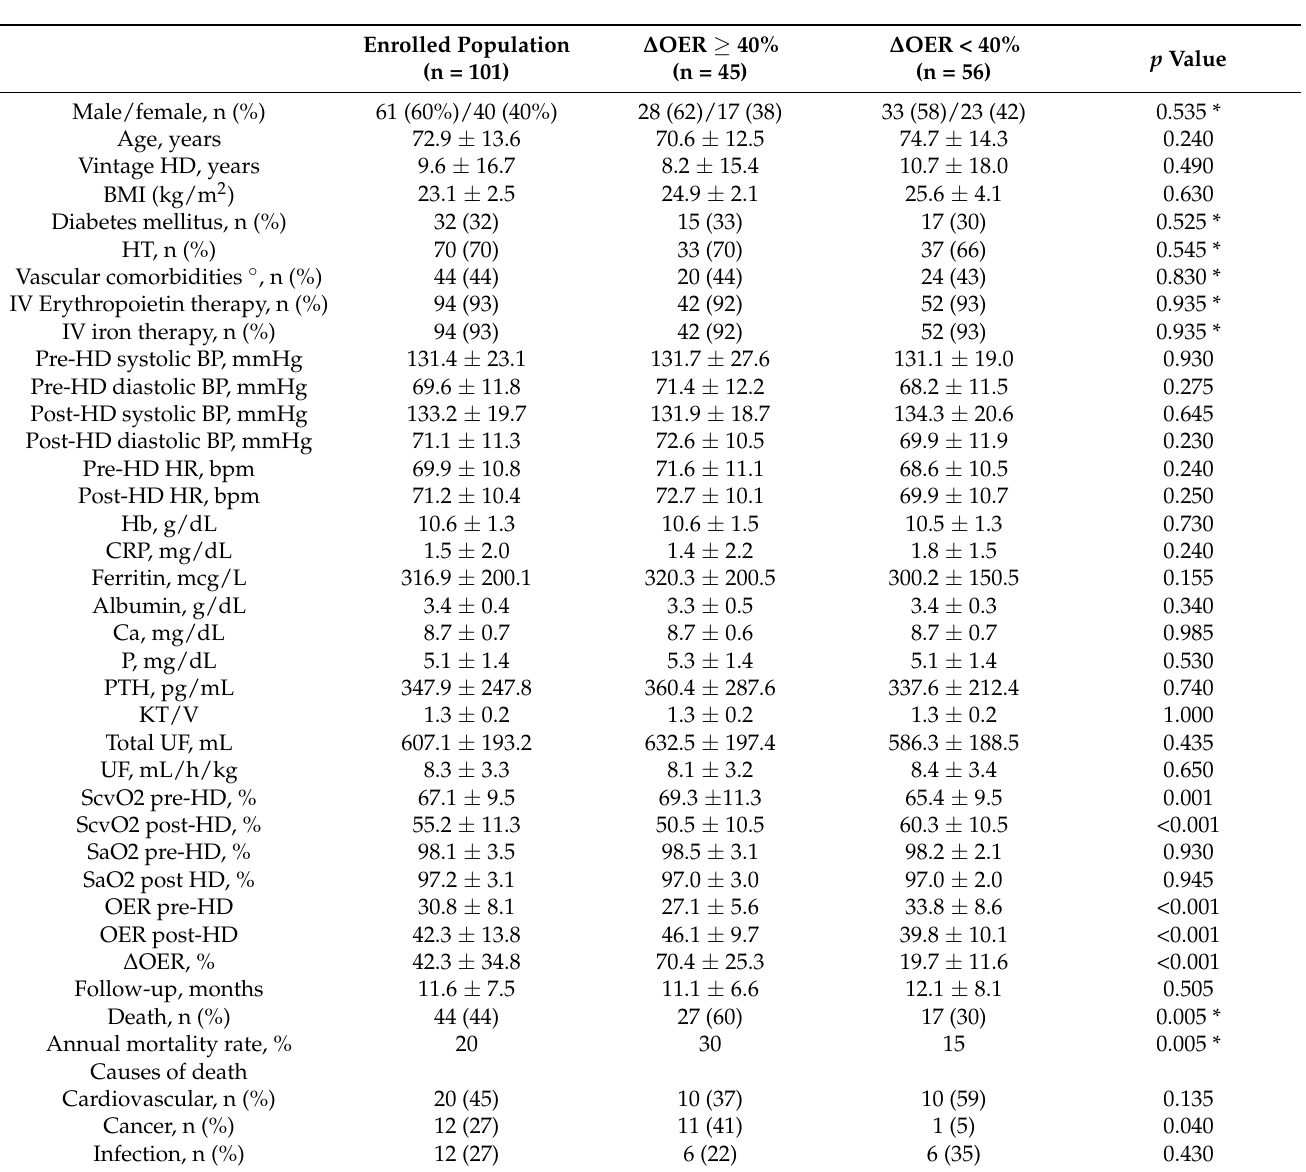
Table 1. Clinical and biochemical characteristics of the enrolled population and of the two sub-groups ( ∆ OER ≥ 40% and ∆ OER <